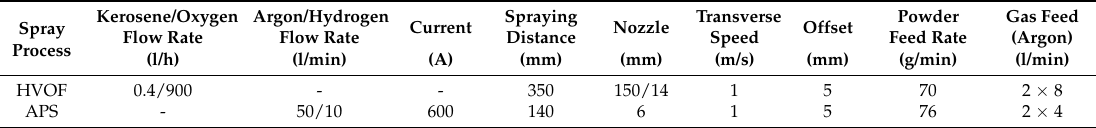
Table 1. The parameters of the thermal-spraying processes conducted with a high velocity oxy-fuel (HVOF) K2 and an atmospheric plasma spraying (APS) F6 system.